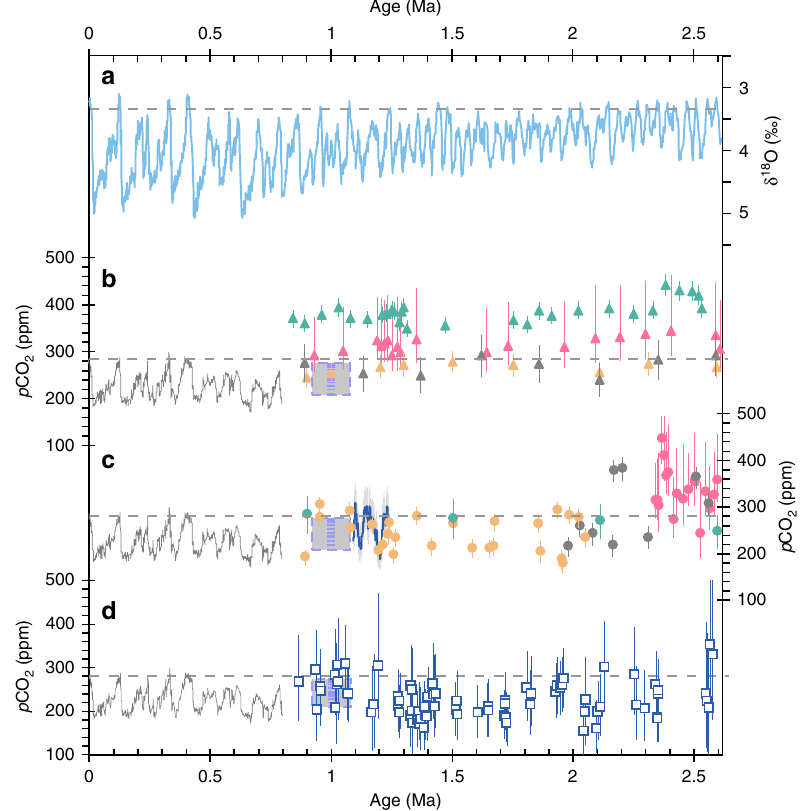
Fig. 5 p CO 2 and benthic δ 18 O data since 2.6 Ma. a Benthic δ 18 O stack 64 . b – d Proxy-derived p CO 2 estimates (2.6 – 0.8 Ma) and ice core data (0.8 – 0 Ma) 36 . Also shown is the blue ice record at ca. 1 Ma 56 . Error bars are 1 σ uncertainties. b Alkenone-derived p CO 2 records (red triangles (ODP 925) 17 ; green and gray triangles (ODP 806 and 1208) 50 ; yellow triangles (ODP 999) 51 ). c Boron-derived p CO 2 records (yellow circles (ODP 668) 49 ; green circles (ODP 999) 51 ; gray circles (ODP 999) 52 ; red circles (ODP 999) 48 ). Recently published high-resolution p CO 2 records across the MPT 62 are shown as the dark blue curve, with a lighter gray band representing the full 95% envelope of the sampled distribution. d Luochuan paleosol-based p CO 2 estimates. Horizontal dashed lines indicate the pre-industrial CO 2 level (280